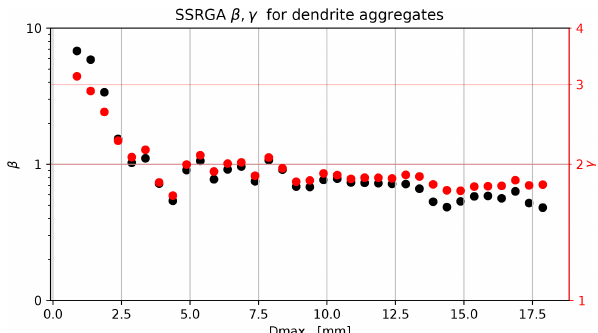
Figure 1. Example of the evolution of the fitted SSRGA parameters β (black) and γ (red) as a function of the snowflake maximum di- ameter for an ensemble of aggregates of dendrites. The snowflakes are assumed to be oriented such that their principal axis (the axis of inertia corresponding to the largest eigenvalue) is aligned with the z axis. The propagation direction of the incident radiation is also the z axis. Note that the scales for the two quantities are logarithmic and that they are reported at the opposite sides of the